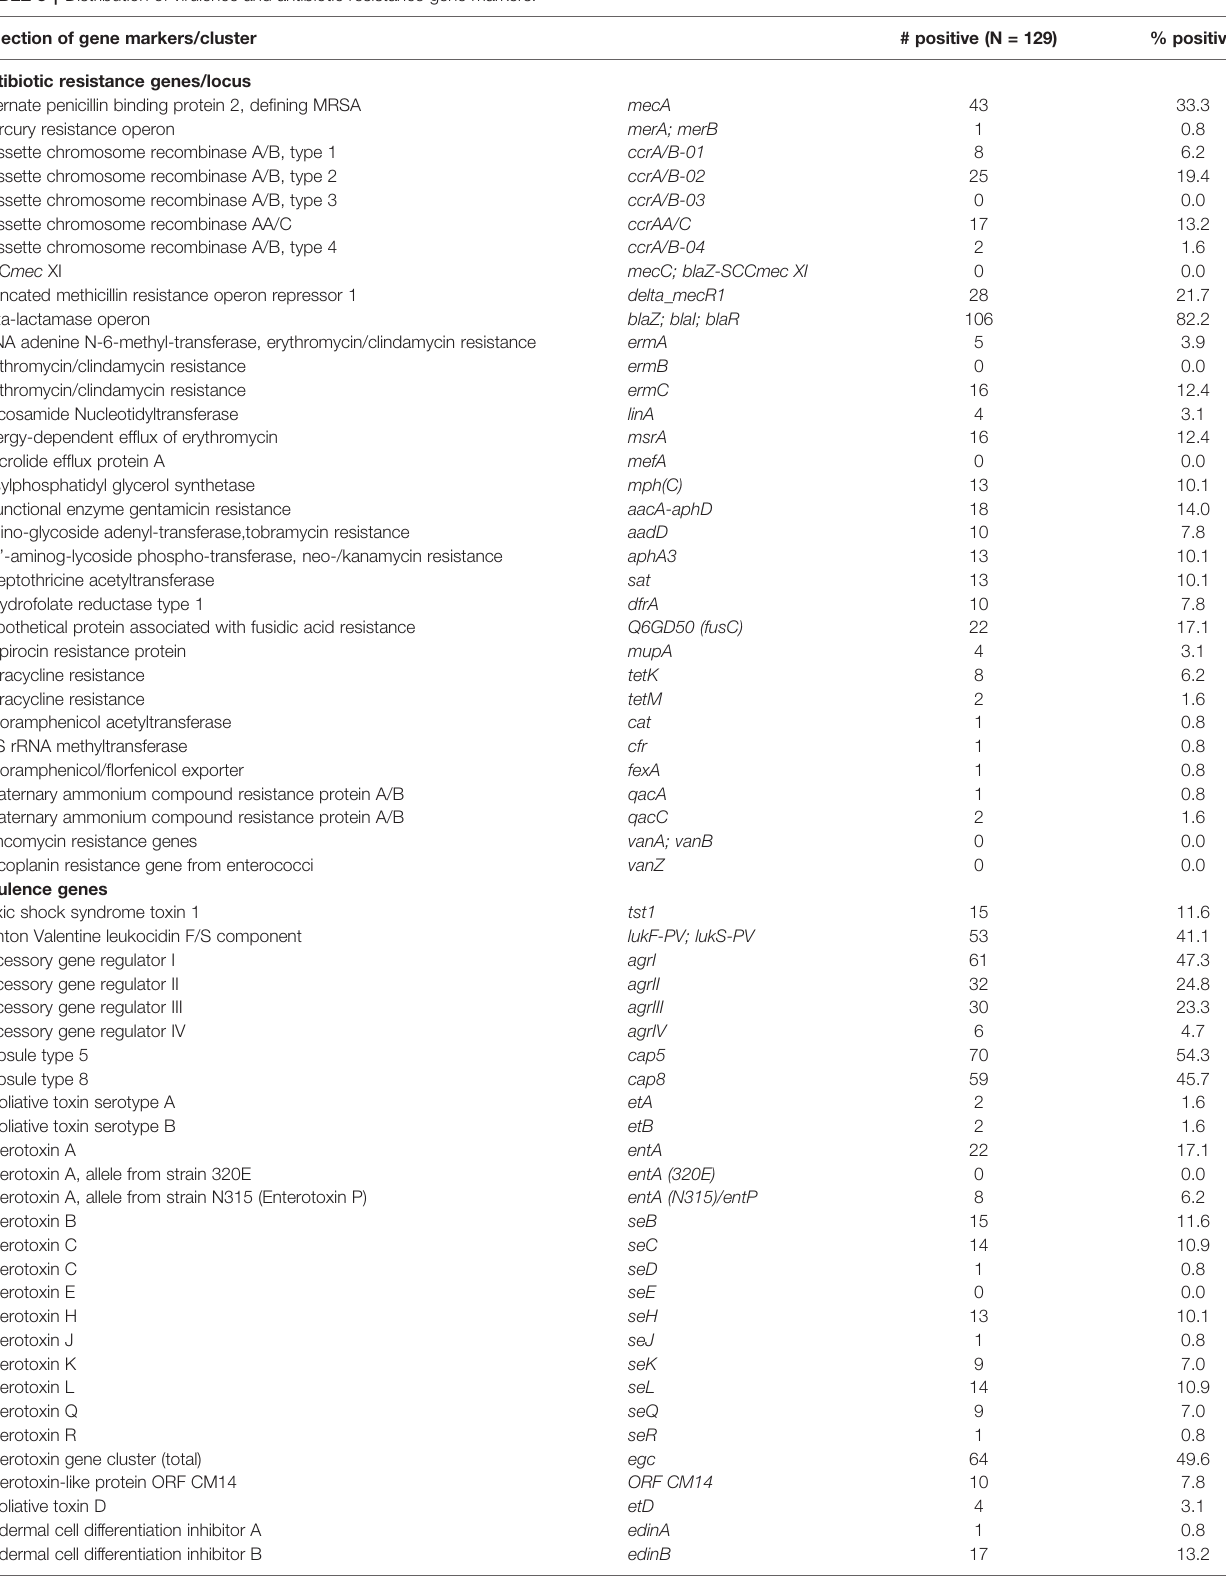
TABLE 3 | Distribution of virulence and antibiotic resistance gene markers. Selection of gene